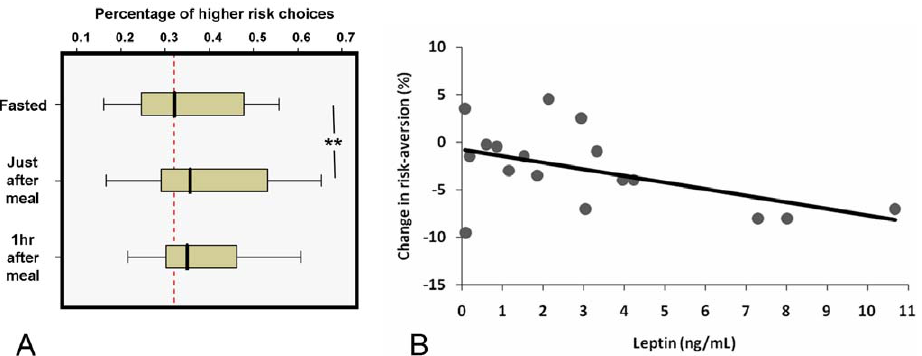
Figure 4. Change in risky choice and baseline adiposity. A. Y-axis shows percentage of trials (n=200) where the riskier (higher variance) lottery was chosen in preference. Red dotted line indicates average baseline fasting percentage across subjects. Box indicates middle quartiles, bar widths show range. There was a significant decrease in risk-aversion (i.e. increase in risky choices) immediately after feeding (p=0.007, N=19). B. Leptin level (x-axis) against change in risk preference for each subject (just after meal – fasted baseline). Best-fitting least-squares estimated linear regression line shown in black (p=0.046, r 2 =0.24).